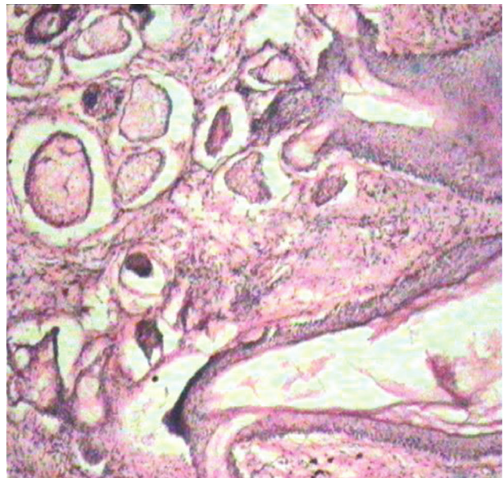
Figure 2: Microphotograph of excised